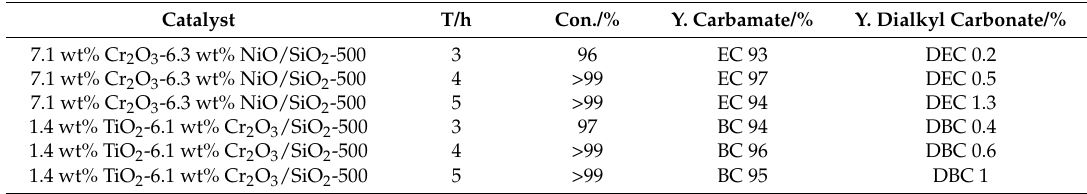
Table 7. Effect of reaction time on synthesis of EC and BC *.